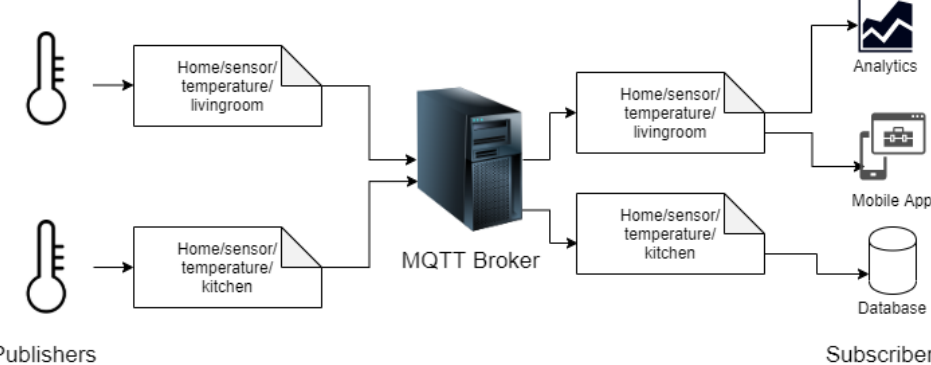
Figure 2. MQTT Components: Publisher, MQTT Broker, and